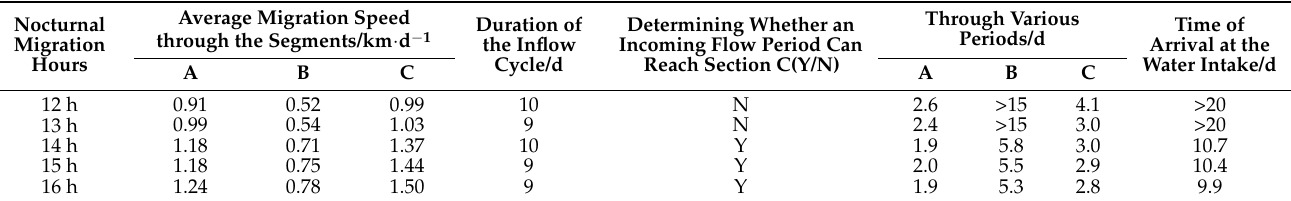
Table 4. Migration times of Acetes in the different night-migration